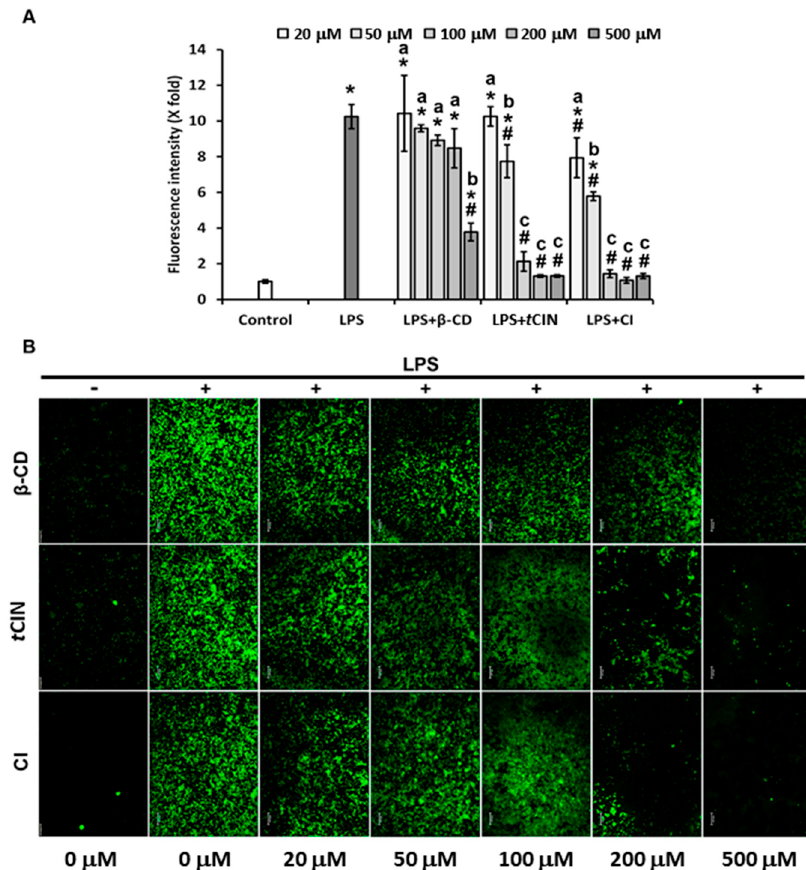
Figure 6. Inhibition of reactive oxygen species (ROS) production by the trans -cinnamaldehyde ( t CIN) and β -cyclodextrin ( β -CD) inclusion complexes (CIs). RAW 264.7 macrophages were seeded in 96-well plates with black walls and transparent bottoms for 24 h, and then subjected to starvation for 18 h. Cells were treated with increasing concentrations of β -CD, t CIN, and CIs for 30 min, and then treated with LPS for 24 h. ROS levels were determined using H2DCFDA, according to the manufacturer’s protocol. ( A ) The fluorescence intensity was measured using a fluorescent microplate reader, and quantified as fold change compared to that of the control group; ( B ) Intensity was visualized using a fluorescence microscope at 100× magnification. The CIs were obtained by molecular inclusion at a 1:1 molar ratio of t CIN and β -CD. Data are the mean ± standard deviation (SD). * p < 0.05 versus the control, # p < 0.05 versus LPS. The different letters indicate p < 0.05 within the same treatment group. LPS, lipopolysaccharide; H2DCFDA, 2 ′ ,7 ′ -dichlorodihydrofluorescein diacetate.